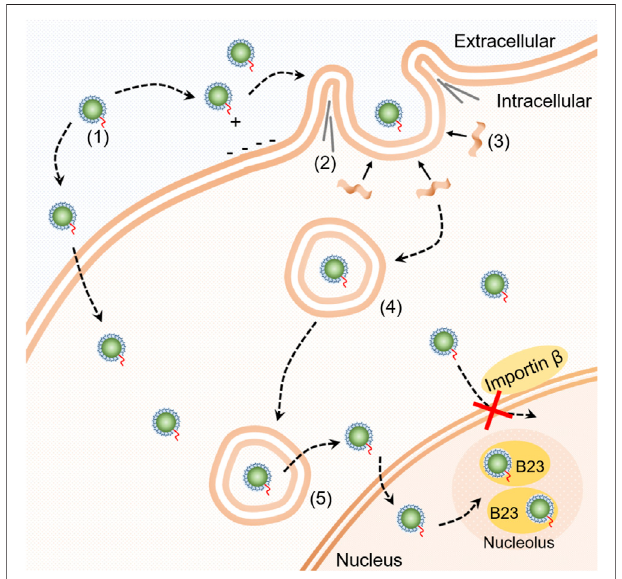
FIGURE 5 | Schematic diagram of the cellular transport pathway of SDot-Tat. (1) SDot-Tat. (2) F-actin. (3) Lipid raft. (4) Early endosome. (5) Late